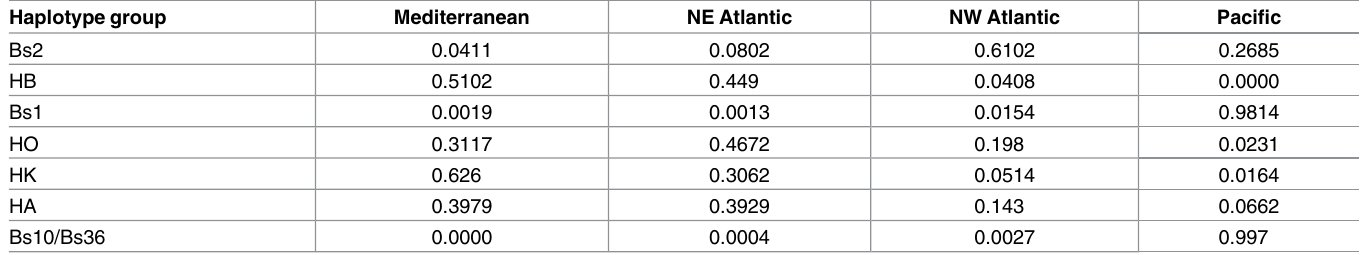
Table 2. Location posterior probabilities for Clade A haplotype groups. Haplotype